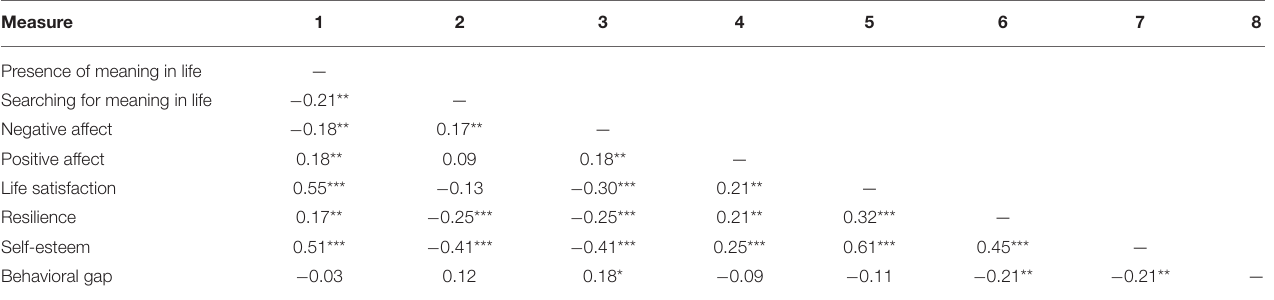
TABLE 1 | Pearson’s correlations between measures of well-being. Measure